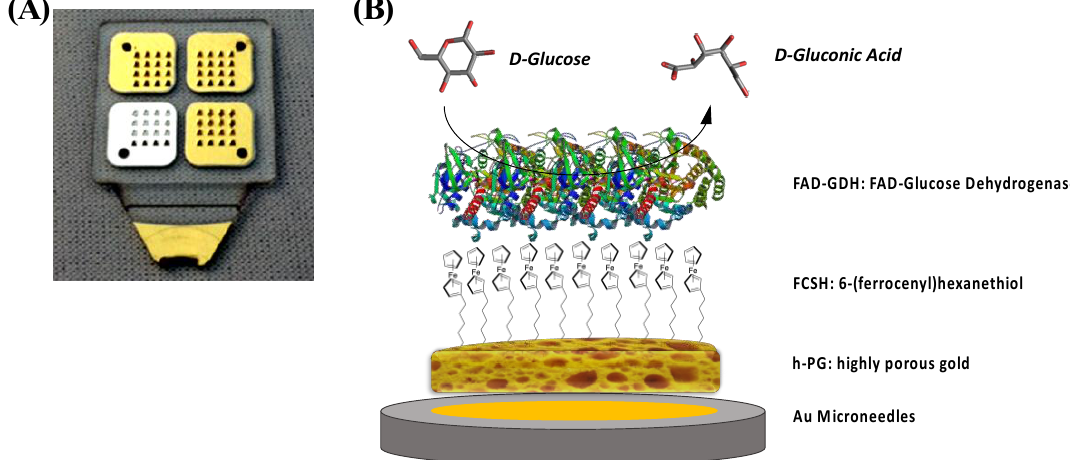
Figure 1. ( A ) Photo of four 4 × 4 microneedle arrays metallized with gold and silver; ( B ) Schematic representation of the highly porous gold (h-PG) / 6-(ferrocenyl)hexanethiol (FcSH) / flavin adenine Figure 1. (A) Photo of four 4 × 4 microneedle arrays metallized with gold and silver; (B) Schematic dinucleotide glucose dehydrogenase (FAD-GDH) / Au microneedles-based glucose biosensor. Figure 1A representation of the highly porous gold (h-PG)/6-(ferrocenyl)hexanethiol (FcSH)/flavin adenine is reproduced from ref. [28] with permission of Elsevier Science ltd dinucleotide glucose dehydrogenase (FAD-GDH)/Au microneedles-based glucose biosensor. Figure 1A is reproduced from ref. [28] with permission of Elsevier Science ltd (2019).